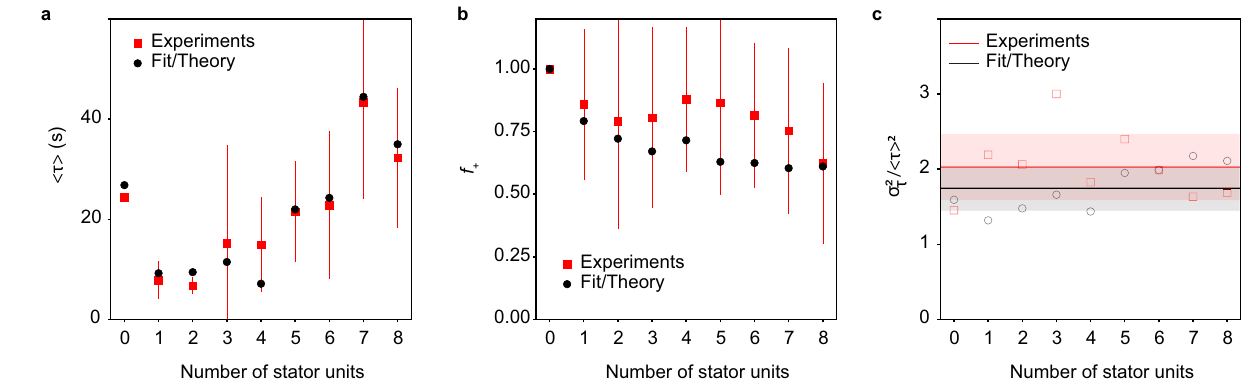
Fig. 3 | Quantitative comparison between experiments and theory. a The averagedwelltime 〈 τ 〉 foreachstatornumber N . b Thefractionofonevents f + for each stator unit number N . c The normalized variance V (cid:4) σ 2 τ = h τ i 2 versus N . The average V over N and the standarddeviation of V over N are shown asthe solid line